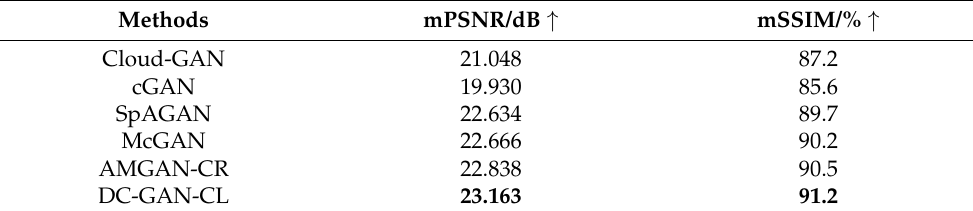
Table 7. Quantitative evaluation of various methods on the Paris test set.